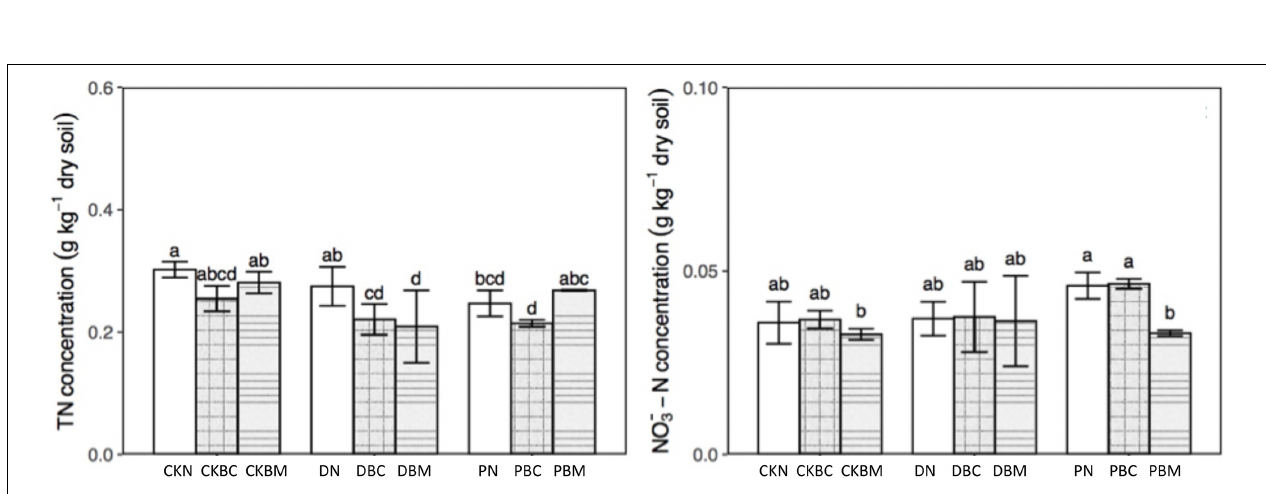
FIGURE 2 | TN and NO 3 − –N concentration of different